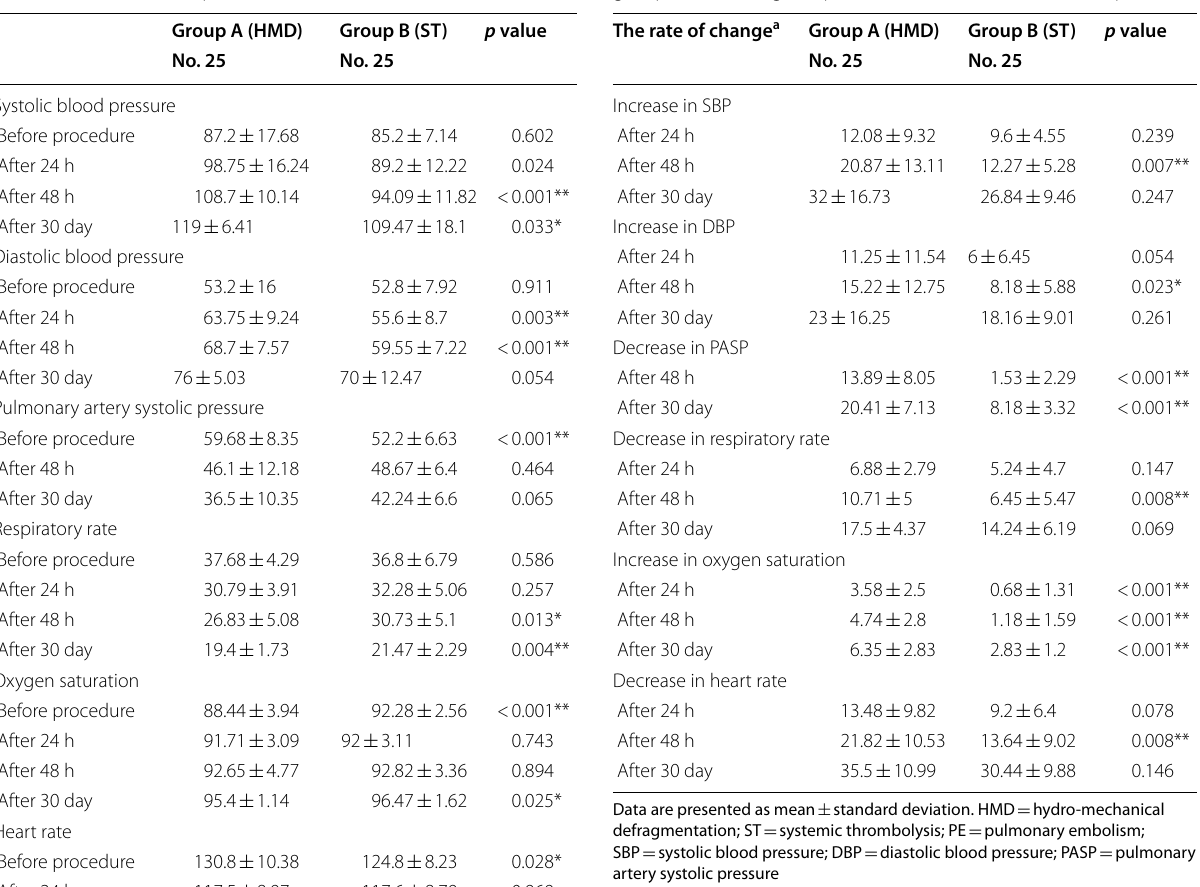
Table 2 Efficacy parameters of the study groups comparing admission and follow‑up results